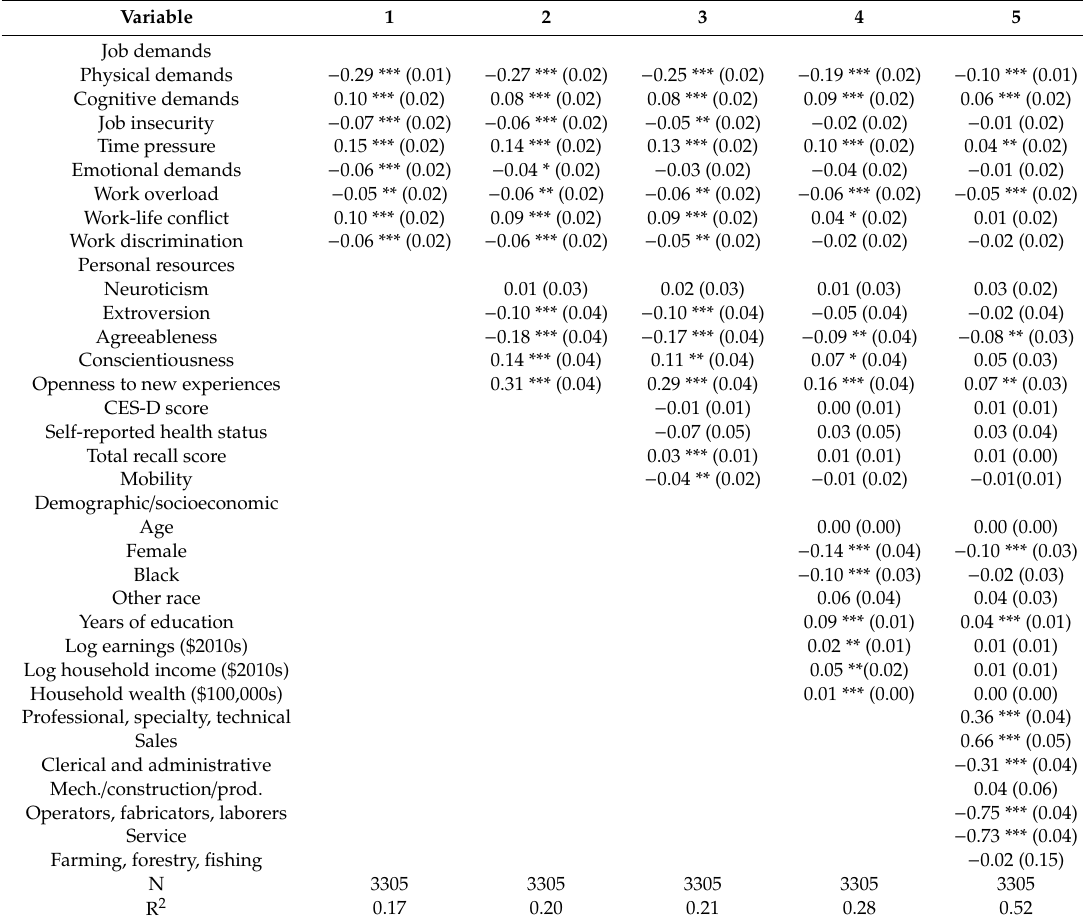
Table 5. Regression analysis predicting objective O*NET job